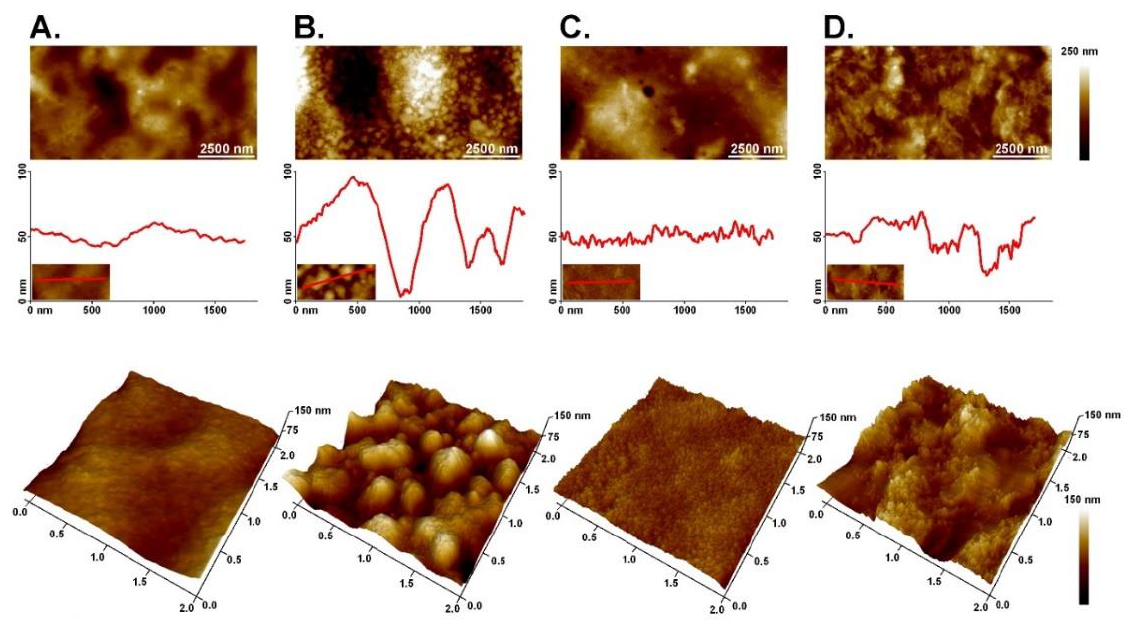
Figure 2. AFM topography images with corresponding cross-sections: ( A ). CHIT – FUR, ( B ). 0.25 HGEL, ( C ). 0.50 HGEL and ( D ). 0.75 HGEL.